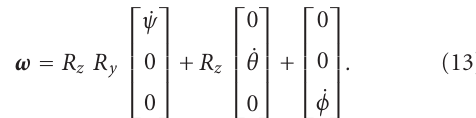
acceleration and ω is the angular velocity. Angular